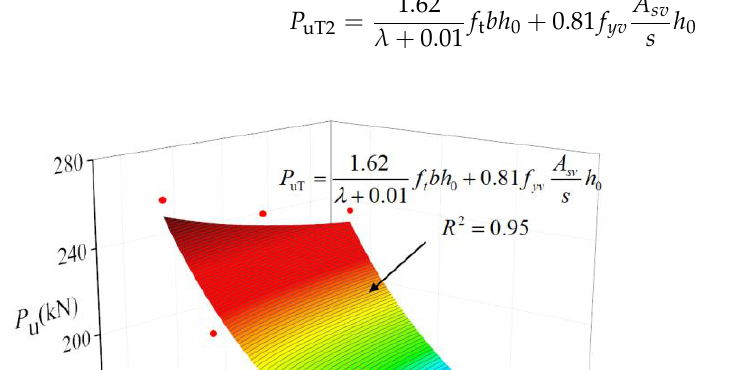
Figure 17. Verification of reduction coefficient.